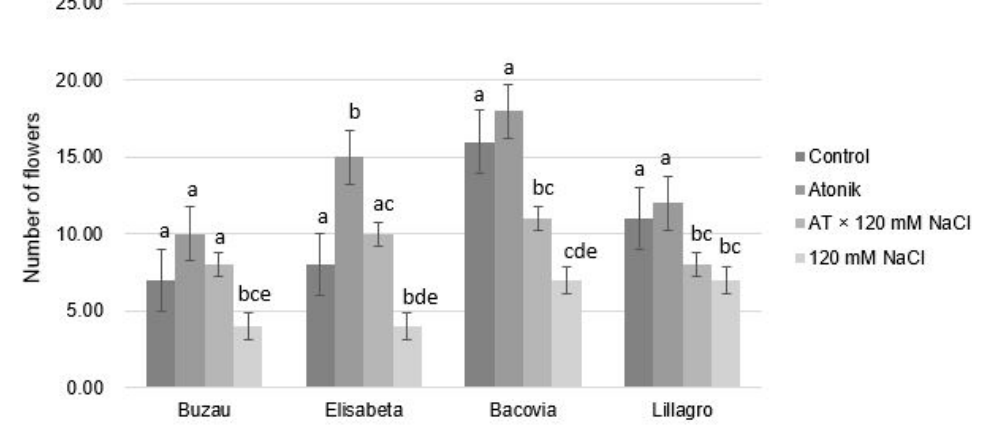
Figure 4. The effect of Atonik biostimulant on the number of flowers per plant under saline stress after the third treatment. Different letters mean significant differences, according to the Tukey test. Error bars indicate ±